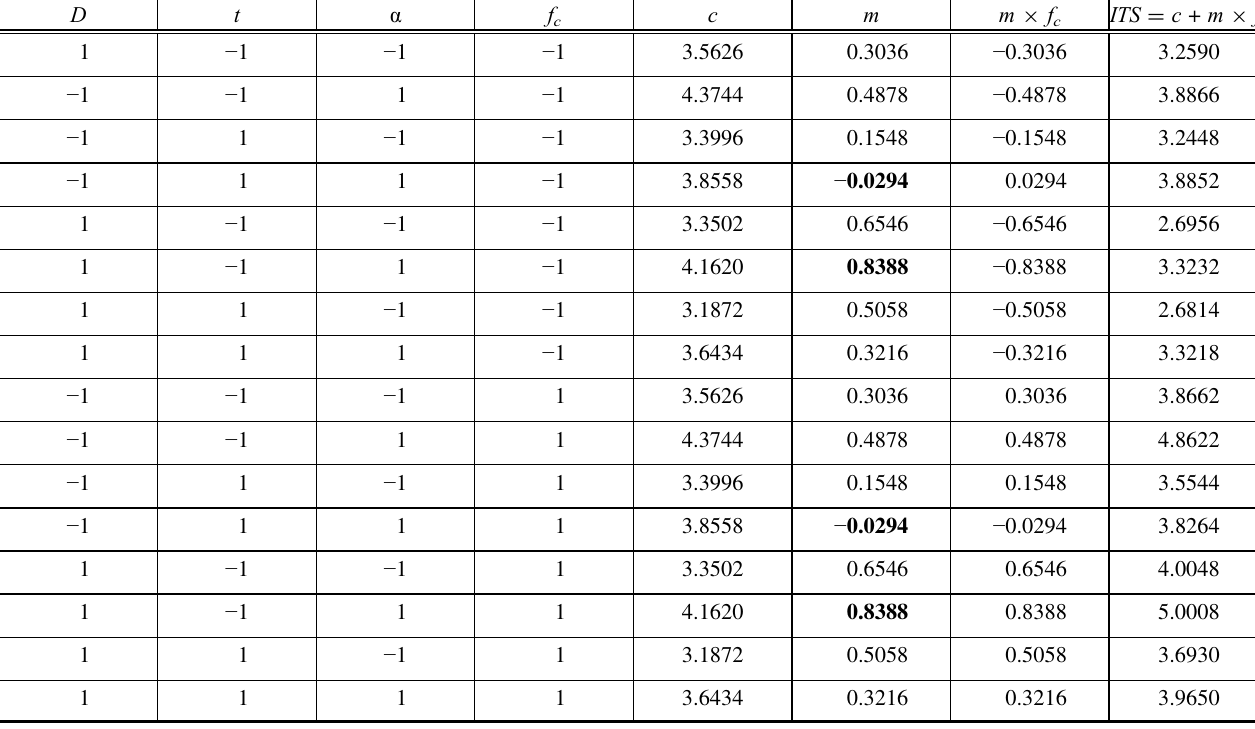
Table 14 Estimation of the Indirect tensile strength (ITS) value using the Reduced model in Eq. (10) and data from Table 12.